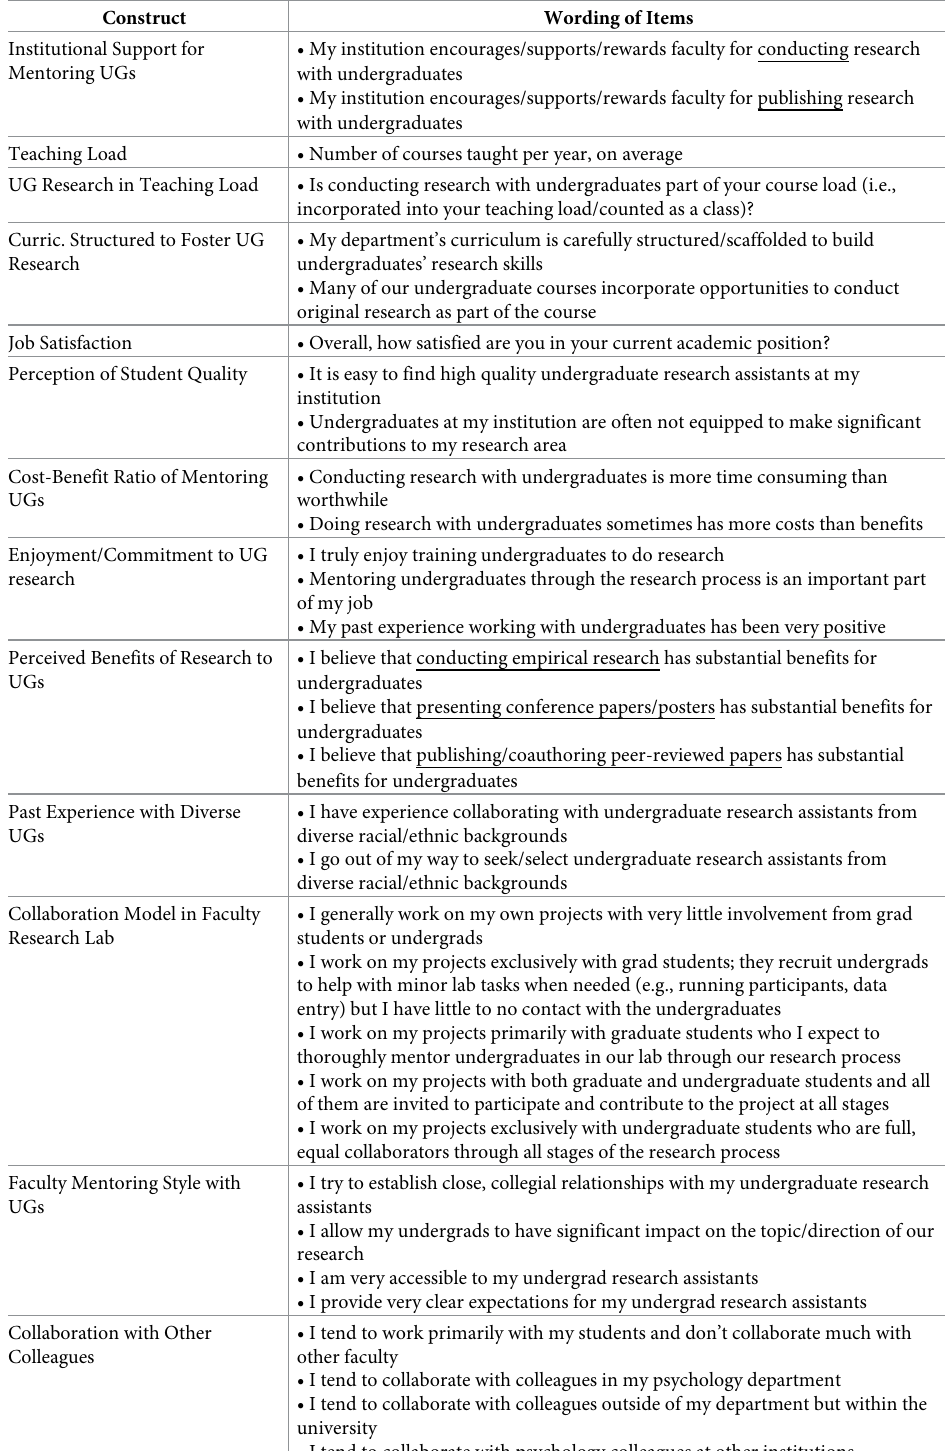
Table 2. Wording of self-report items for primary variables (UG =